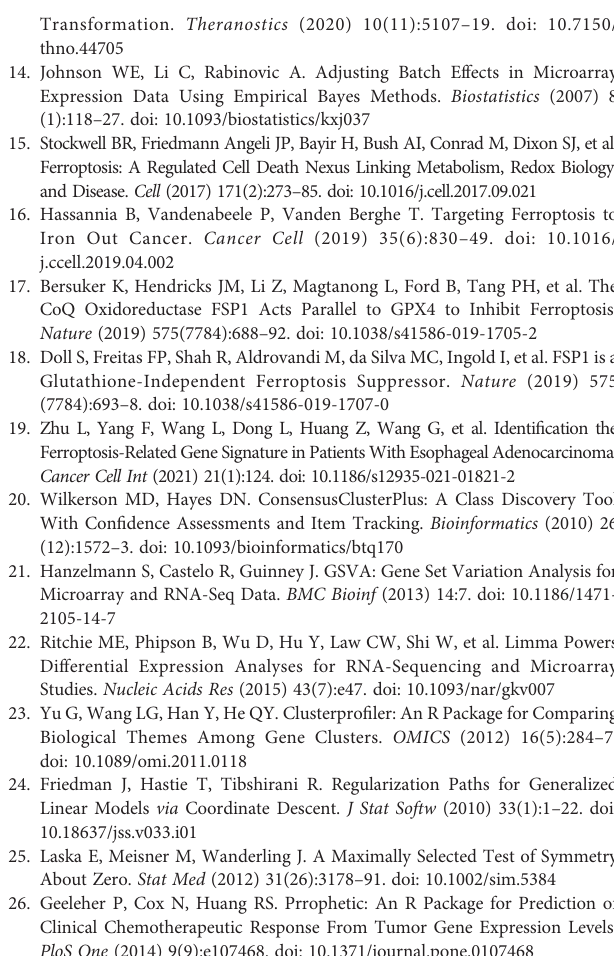
Supplementary Figure 1 | The causal interaction of the key gene ALOX5 in DisNor. The database consisted the direct targets and their intracellular localization of